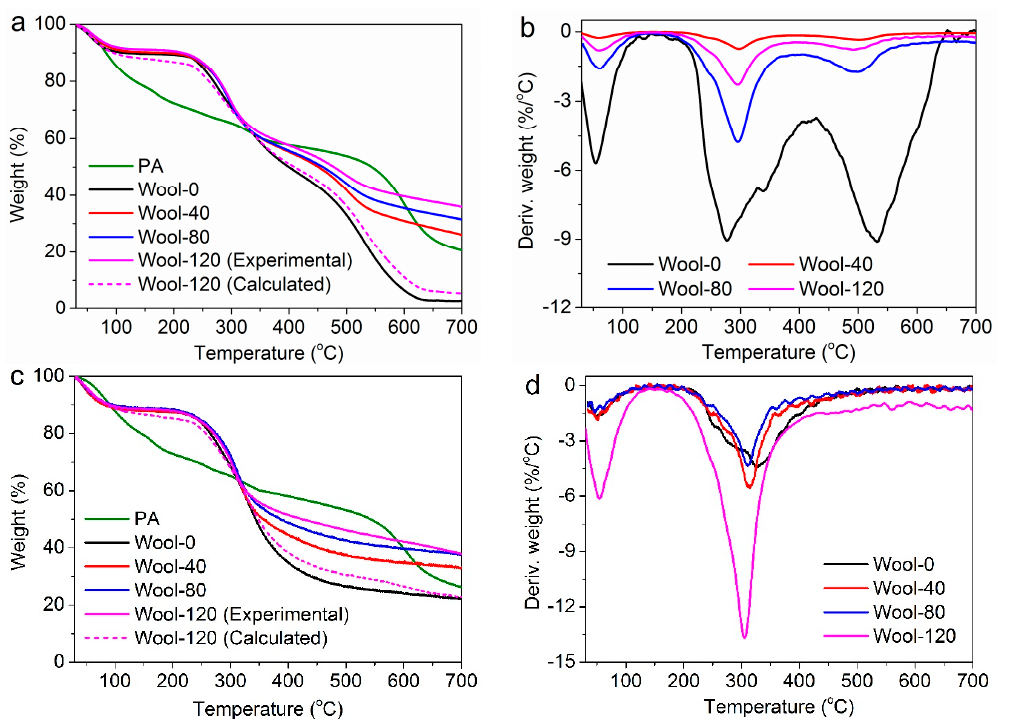
Figure 8. TG and DTG curves of wool fabrics under air ( a , b ) and nitrogen ( c , d ). Table 2. TG data of wool fabrics under air and nitrogen.